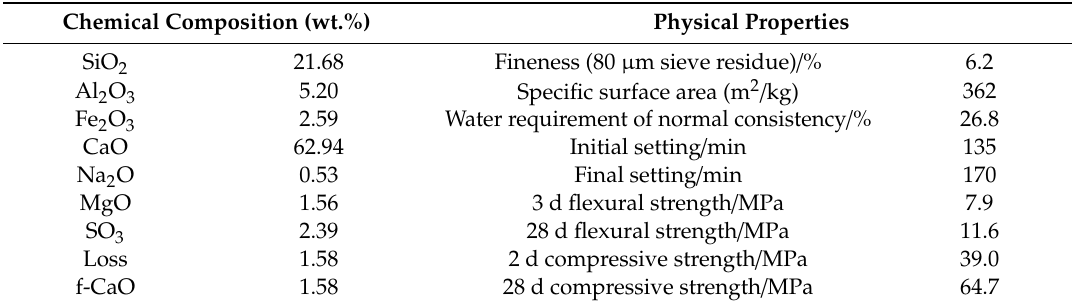
Table 1. Chemical composition and physical properties of cement.